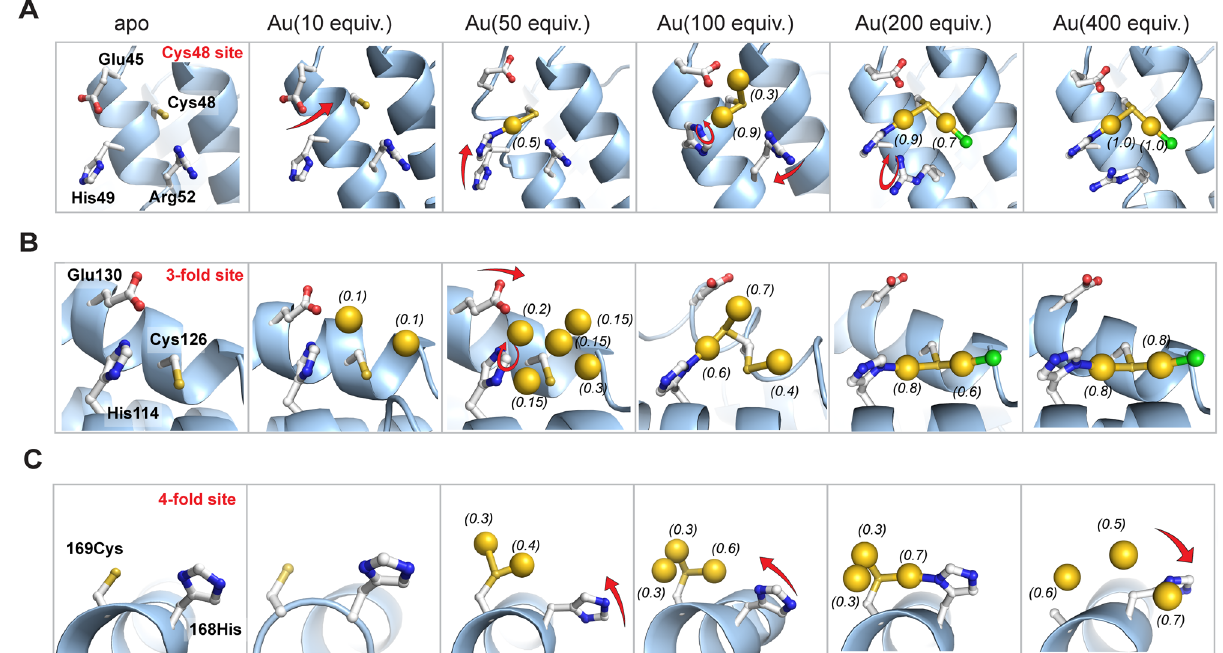
Fig. 3 Accumulation process of Au ions into apo-R168H/L169C-rHLFr cage. The conformational changes of key residues located at the Cys48 site ( A ), 3-fold site ( B ), and 4-fold site ( C ) with the stepwise increase of Au precursor concentration. The Au/Cl atoms are shown as yellow/green spheres. The occupancies of Au atoms were annotated next to the sphere models. Figures were made in